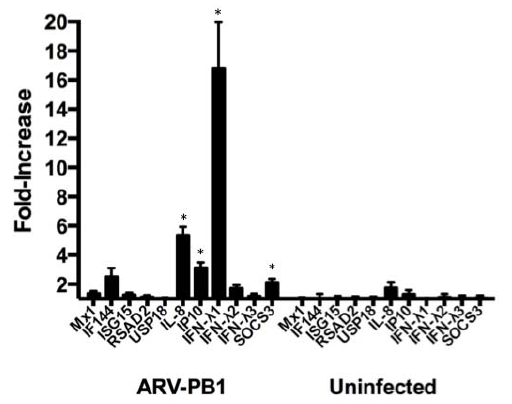
Figure 5. Expression of interferon-stimulated genes (ISGs). Huh-7 cells (5 × 10 5 ) were infected at a MOI of 5 and messenger RNA (mRNA) was collected for analysis at 6 hours post-infection. Transcription of the analyzed ISGs was analyzed by quantitative real-time polymerase chain reaction (PCR) with glyceraldehyde 3-phosphate dehydrogenase (GAPDH) as a housekeeping gene and expressed as a fold-change compared to uninfected cells (35). Data represent the mean from six replicate experiments, with error bars showing the standard error of the mean. Samples were compared using Student’s t -test with significant differences indicated by * p ≤ 0.05.